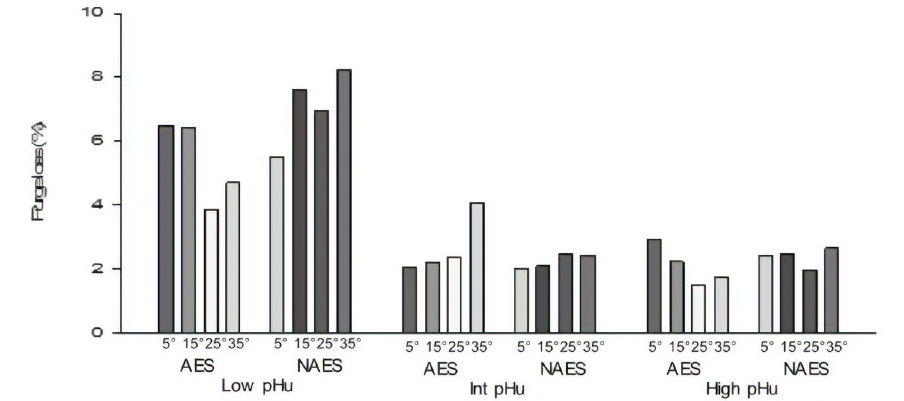
Figure 5. Effect of AES and various pre-rigor holding temperature (for 3 h) methods on purge loss (14 days post mortem) of low, intermediate and high pHu beef M. longissimus lumborum samples. AES, additional electrical stimulation; NAES, no additional electrical stimulation. Low pHu (n = 3), Int (intermediate) pHu (n = 3), and high pHu (n = 6). Treatment effect [AES vs ES] (p>0.05); pH effect (p<0.001); temperature effect (p = 0.014); interaction effect (stimulation×temperature) (p = 0.006); (pH×temperature) (p = 0.011); (stimulation×temperature×pH) (p = 0.002, standard error of difference = 0.63).